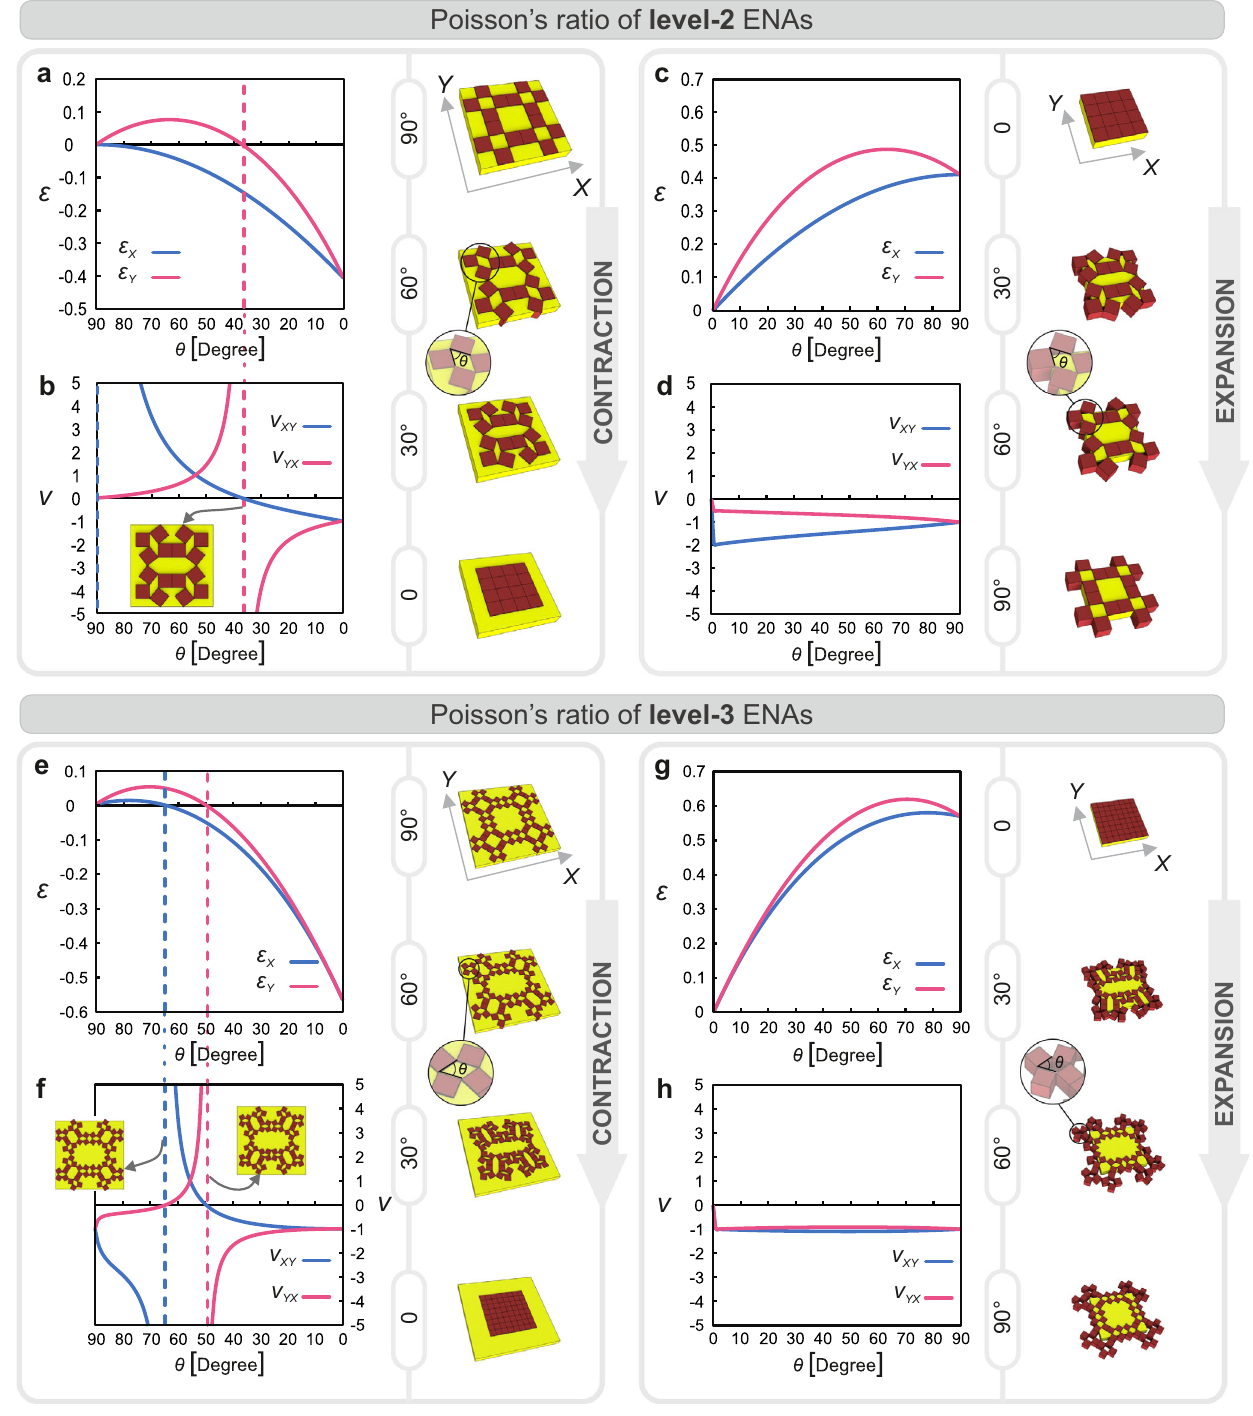
Fig. 4 In-plane Poisson ’ s ratio in hierarchical ENAs of levels 2 and 3. a , b Plots of the strains and Poisson ’ s ratio of the contraction of the level-2 structure. c , d Plots of the strains and Poisson ’ s ratio of the expansion of the level-2 structure. e , f Plots of the strains and Poisson ’ s ratio of the contraction of the level-3 structure. g , h Plots of the strains and Poisson ’ s ratio of the expansion of the level-3 structure. 3D assemblies are used to exhibit the deformation of the models. Yellow squares represent the initial dimensions of the structures; when during the deformation process any of the two instantaneous dimensions of the structures are equal to the respective dimensions of the yellow squares, the corresponding deployment angle is a critical As depicted in Fig. 3, the numerical results of motion simulation error within the range of ±3%. Sources of error affecting the and the analytical outputs of the mathematical model were fully experimental results include: (1) the use of polyurethane foams in compatible. Moreover, experimental results based on physical the fabrication of the physical models, in which the elements are models acceptably validated the analytical/numerical data with an not perfectly rigid and the hinges are not ideal rotational